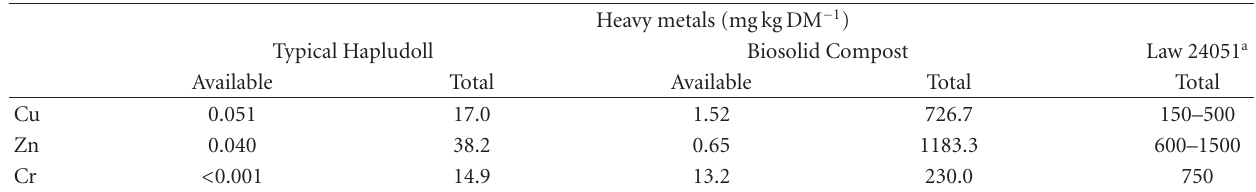
Table 3: Heavy metals content (in ppm) of soil samples and composted biosolids, and the maximum levels of total heavy metals established by Argentinean law (Hazardous wastes regime: soil quality guide).